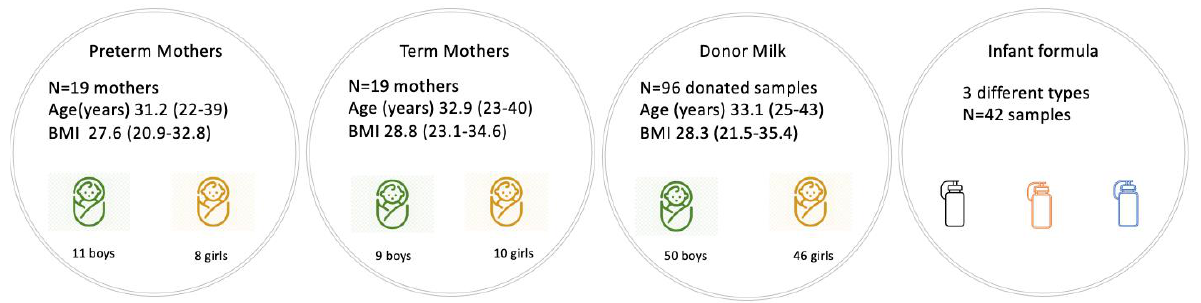
Figure 1. Measured samples and maternal data.